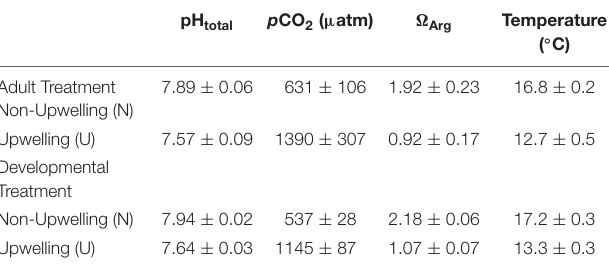
TABLE 1 | Carbonate chemistry parameters for adult (U and N) and developmental (U and N)